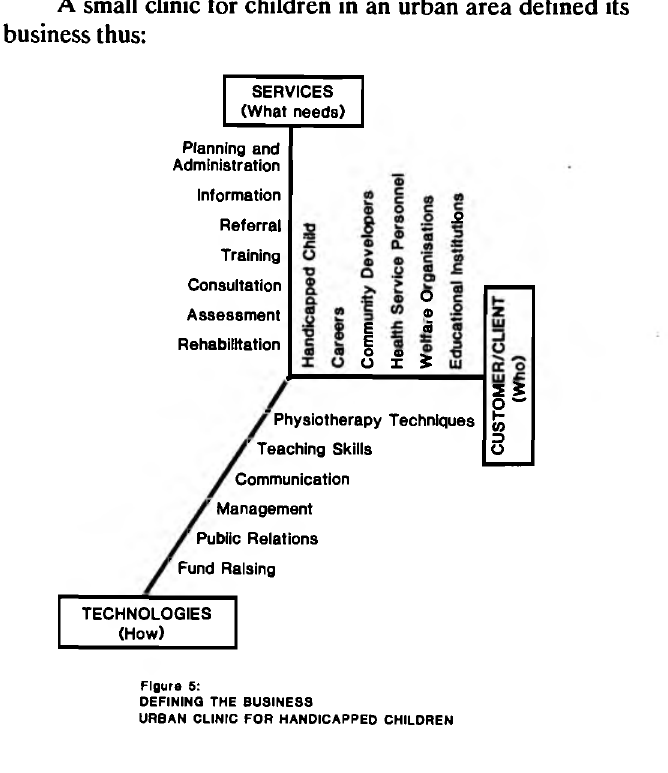
Figure 5: DEFINING THE BUSINESS URBAN CLINIC FOR HANDICAPPED CHILDREN